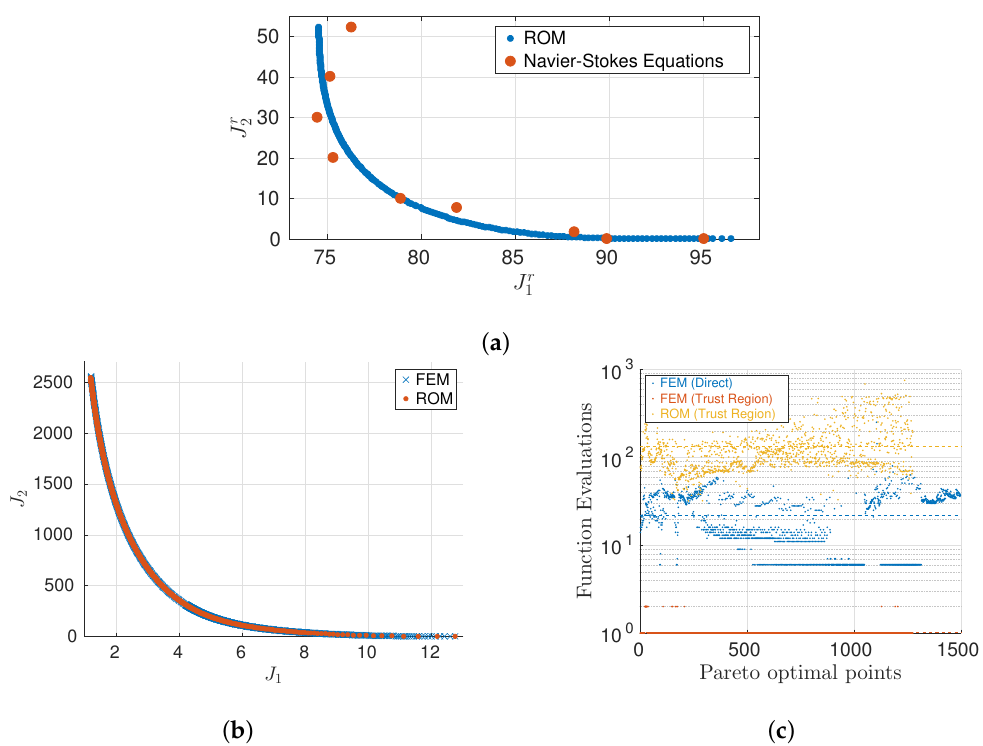
Figure 7. ( a ) Pareto front for an MOCP involving the Navier–Stokes equations (flow stabilization vs. cost), solved by coupling of an ROM (created once in advance) with the reference point method. Although we observe acceptable agreement, convergence cannot be guaranteed. ( b ) Pareto front for a heat flow MOCP (reference tracking vs. cost), solved by the TR-POD approach coupled with the reference point method. Convergence is achieved while reducing the number of expensive finite element (FEM) evaluations by a factor of ≈ 22, cf. ( c